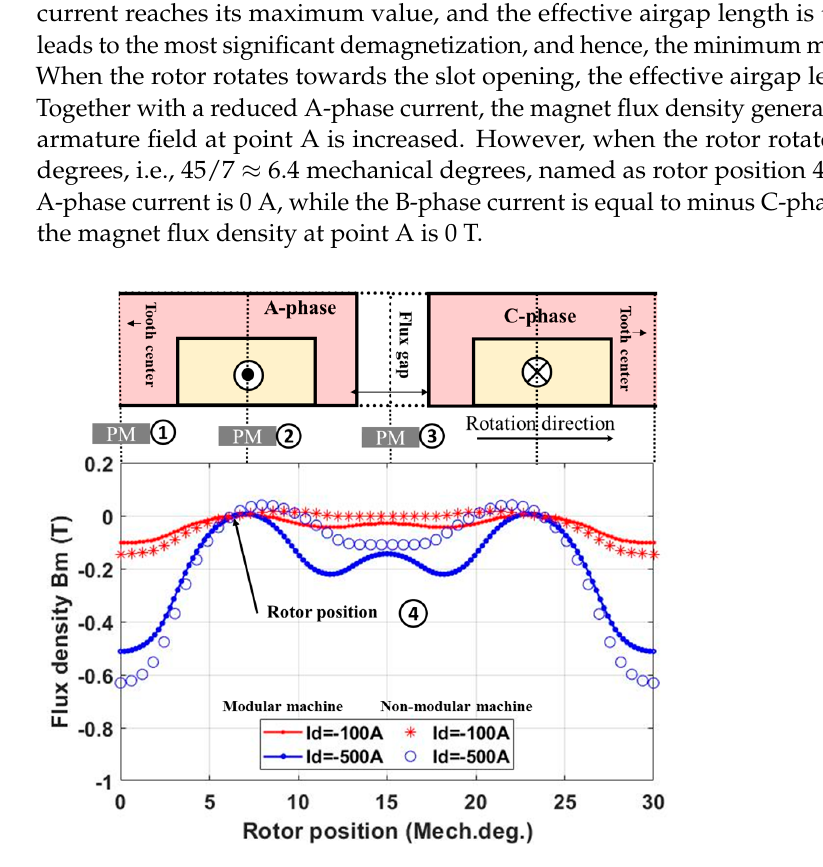
Figure 11. The magnet flux density (radial component) at point A generated by an applied 3-phase armature current at 20 °C for the modular machine with different load currents.